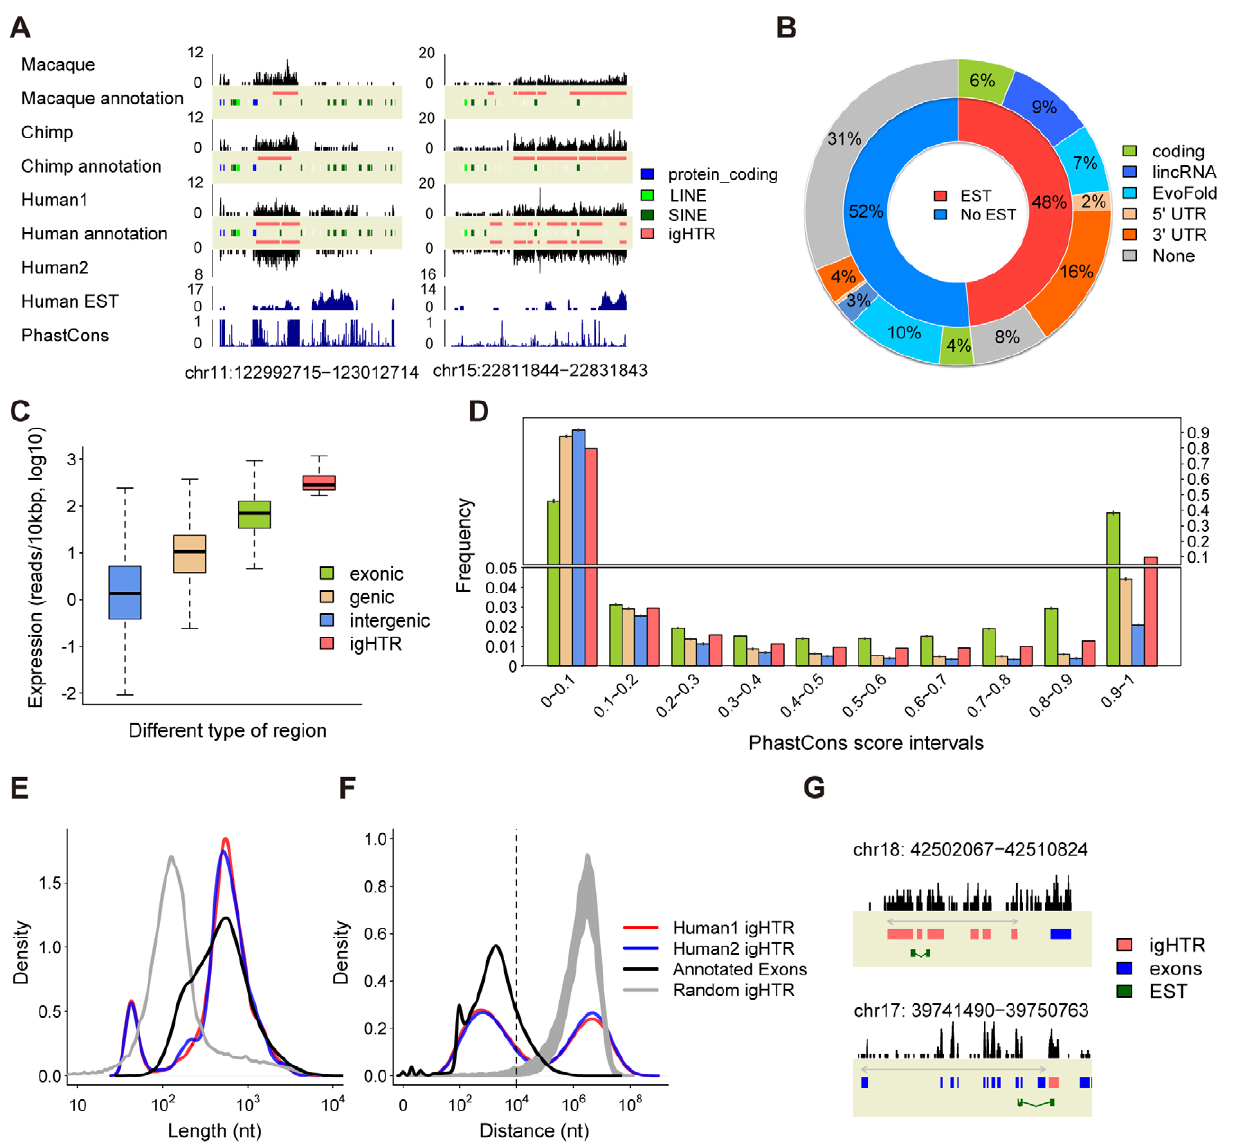
Figure 2. Characteristics of intergenic transcripts. (A) Examples of igHTR. The black track shows sequence reads density (in counts) in the four samples studied. The blue tracks show human EST density and PhastCon scores. (B) igHTR categories. The inner circle shows the proportion of igHTR with (red) or without (blue) EST support. The outer circle shows proportions of igHTR with protein-coding potential (green), supported by lincRNA (blue) or EvoFold (light blue) ncRNA predictions, adjacent to gene’s 5 9 -UTR (light orange) or 3 9 -UTR (orange), and uncharacterized igHTR (grey) among EST-supported and non-supported igHTR. (C) Expression levels within intergenic regions (blue), genic regions including both exons and introns (light orange), exons (green), and igHTR (red). (D) Sequence conservation of nucleotides in human exons, genic regions, intergenic regions, and igHTR (all colors as on the panel (C)) based on phastCon scores among 18 placental vertebrates genomes. PhastCon scores close to 1 indicate high conservation. The heights of the bars show mean value and error bars show 95% confident intervals based on sampling of the same number of nucleotides as located within igHTR from the corresponding genomic regions 1,000 times. For igHTR, the values are based on all nucleotides located within them. (E) Size distributions of igHTR in the two human samples (red - Human1, blue - Human2), annotated human exons (grey), and exonic HTR (black) (F) Distributions of genomic distances between nearest pairs of igHTR (red – Human1, blue – Human2), annotated exons (black), and simulated randomly distributed igHTR (grey). The dashed line shows 10 kb distance. (G) Examples of splicing within igHTR clusters (red) and between annotated genes (blue) and downstream igHTR supported by EST (green). simulation, p , 0.01) between igHTR and large intergenic non- coding RNA (lincRNA) identified in mouse and human cell lines [18,19], involving 19% of all identified human igHTR. An